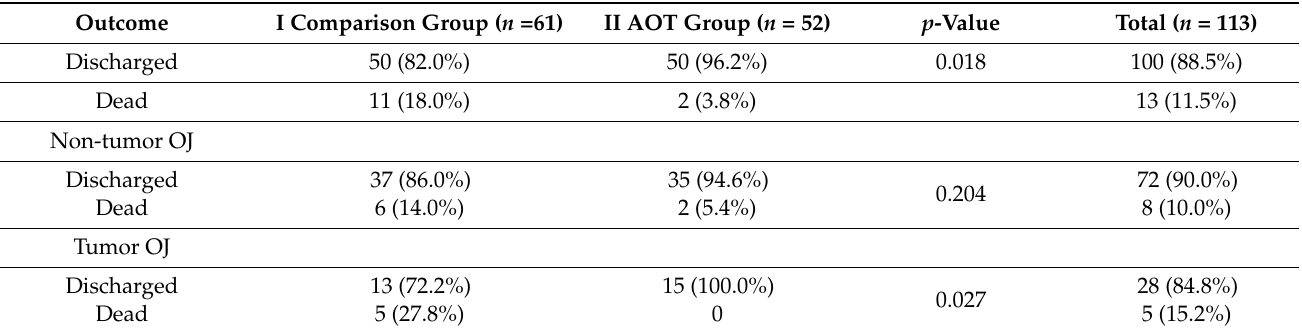
Table 6. Hospital outcome of patients in the study